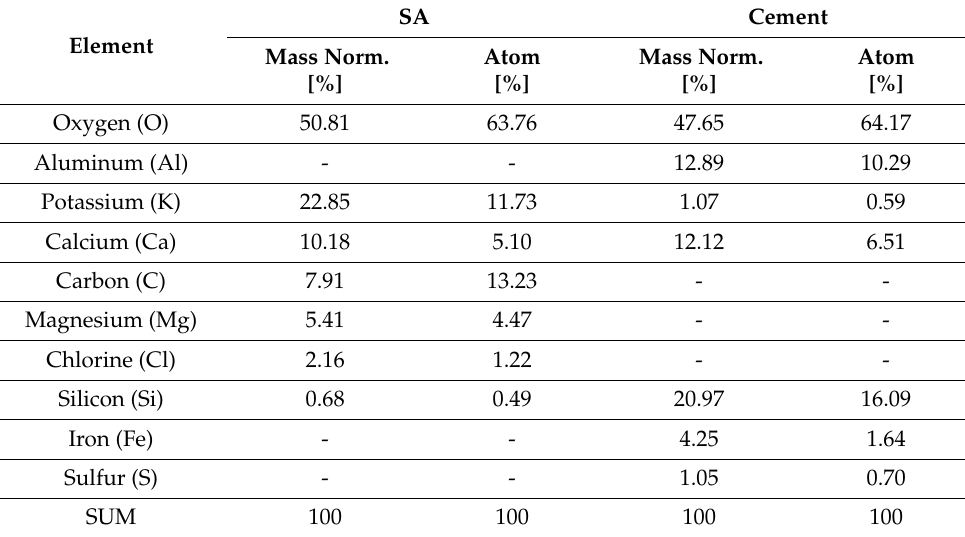
Table 2. EDS analysis of the SA and cement: Quantitative